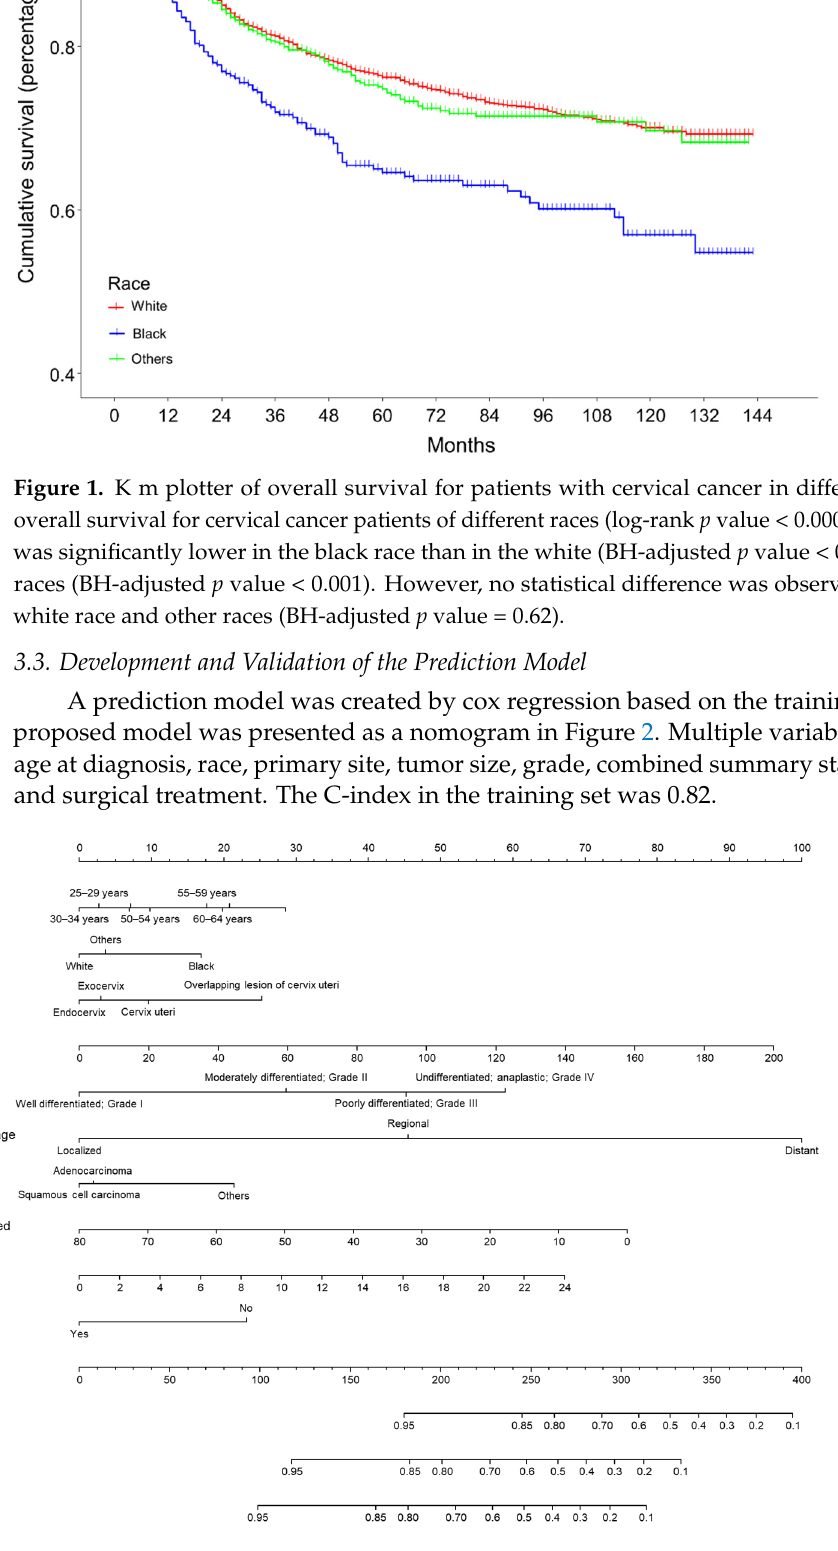
Figure 2. A nomogram for predicting the overall survival probability in patients with cervical cancer.